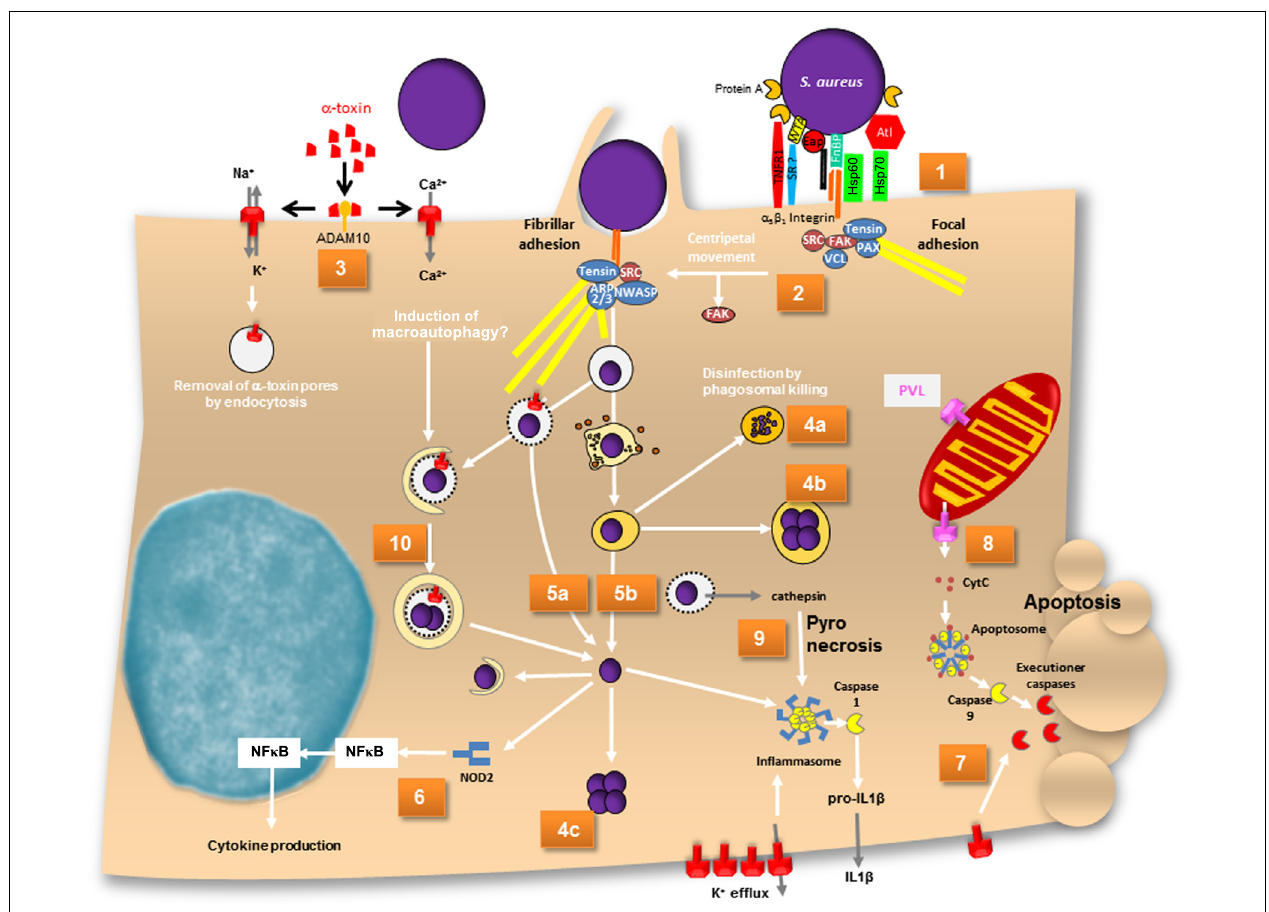
FIGURE 1 |A map of intracellular fates of S. aureus. (1) α 5 β 1 integrins are sequestered by FnBP-dependent fibronectin cross-linking at focal adhesions. (2) Centripetal movement and loss of FAK lead to development of fibrillar adhesions, at which phagocytic cups are formed and bacteria are eventually endocytosed. (3) Assembly of α -toxin pores on the plasma membrane of host cells leads is dependent on ADAM10. α -Toxin pores are permeable for cations. Ca 2 + has been reported to induce macroautophagy. (4a) Bacteria are disinfected by phagolysosomes or (4b) survive and grow within endosomes or (4c) in the cytoplasm after phagosomal escape. (5a) Phagosomal escape can be mediated by α -toxin in cystic fibrosis cells and (5b) also by a combination of phenol-soluble modulins and phospholipases. (6) Cytoplasmic S. aureus peptidoglycan is recognized by NOD2, which activates NF κ B and results in cytokine production. (7)The mode of cell death induced by S. aureus is not completely understood.While caspase-independent cell death exists, α -toxin is capable of inducing extrinsic apoptosis. Upon alpha-toxin induced potassium efflux caspase 2 has recently been shown to lead to mitochondrial outer